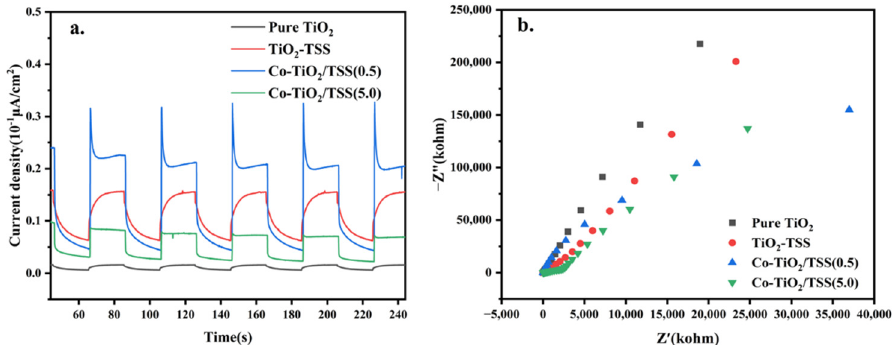
Figure 10. ( a ) Transient J-t photo response under visible-light illumination and ( b ) Nyquist plots of pure TiO 2 , TiO 2 -TSS, Co-TiO 2 /TSS(0.5), and Co-TiO 2 /TSS(5.0).